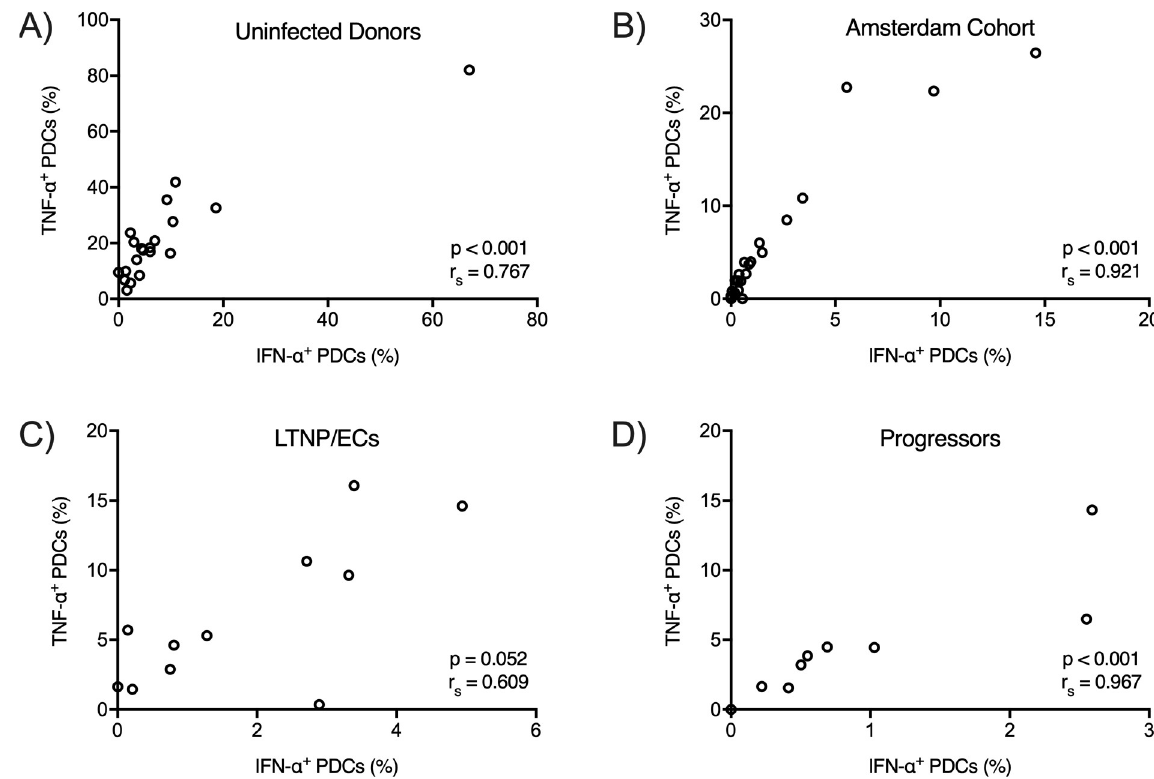
Fig 3. IFN- α and TNF- α production correlates in PDCs following TLR7 receptor ligation by HIV-1 ADA . PDC TLR7 receptors were stimulated by HIV-1 ADA , and cytokine secretion was inhibited after 4 hours. Anti-IFN- α and anti-TNF- α antibodies were used to measure intracellular IFN- α and TNF- α production by flow cytometry. P and r s values were calculated by the Spearman rank correlation.